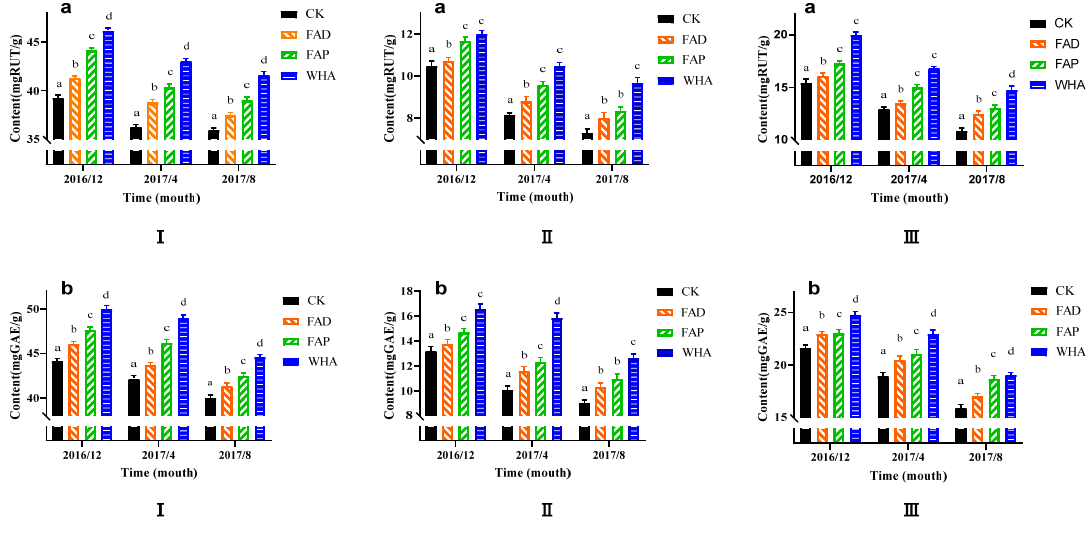
Figure 1. The effects of humic/fulvic acid fertilizer on the contents of total flavonoids ( a ) and total phenols ( b ) of lemon fruits. I, peel; II, pulp; III, seed. Different small letters in this figure indicate the significant differences among different treated groups ( p < 0.05).